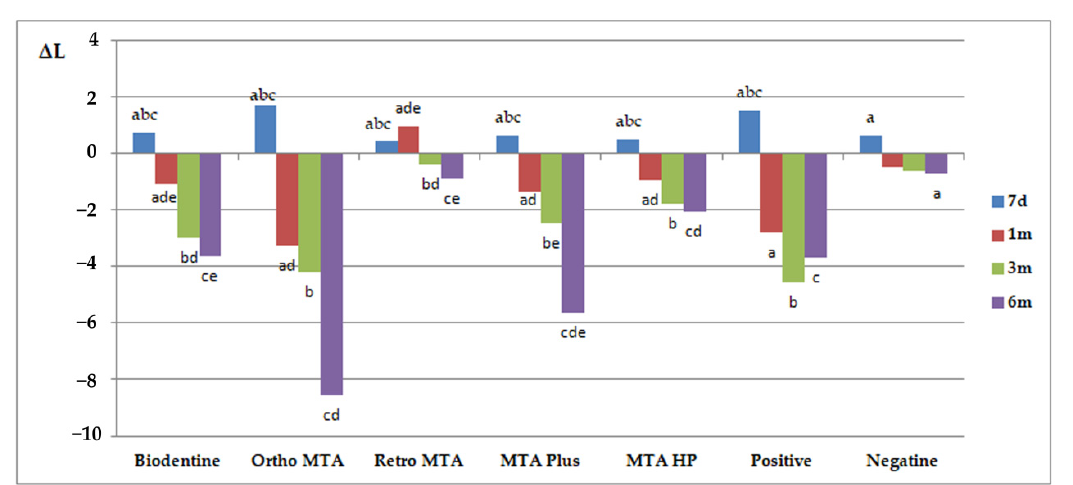
Figure 3. Mean Δ E values of tooth discolouration for different durations Similar letters indicate statistically significant differences between different time points within a material group ( p < 0.05); Biodentine (a 0.0041; b 0.0065; c 0.0191; d 0.0191); Ortho MTA (a 0.0284; b 0.0015; c 0.0052; d 0.0284); Retro MTA (a 0.0413; b 0.0073; c 0.0493); MTAPlus (a 0.0343; b